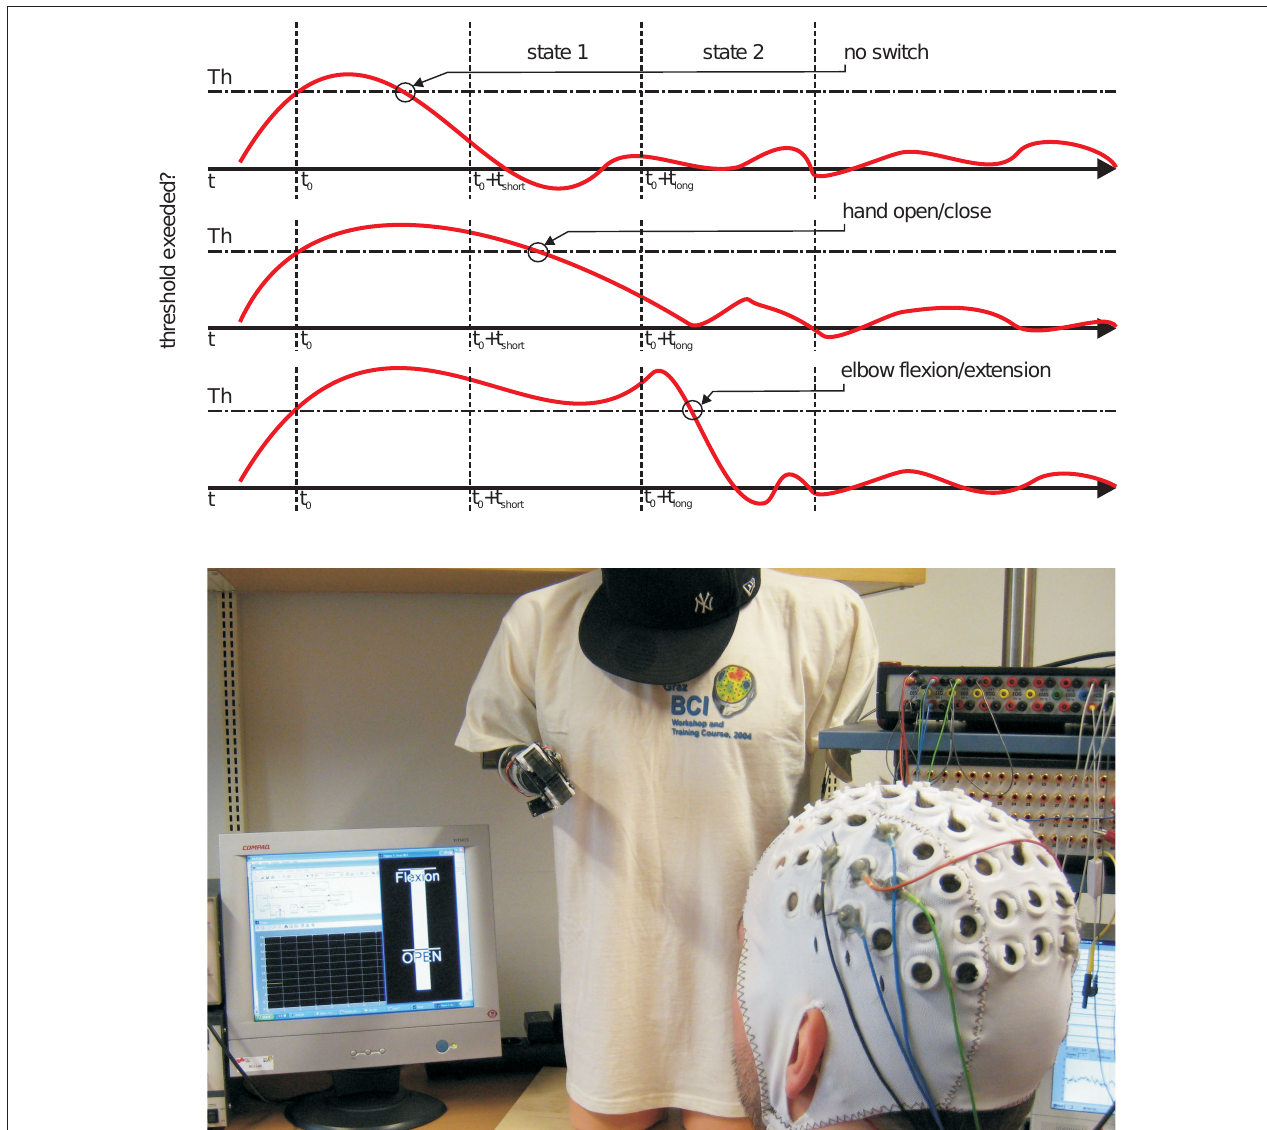
Figure 3 | Principle of the pulse-width coded switch and one subject during artificial arm